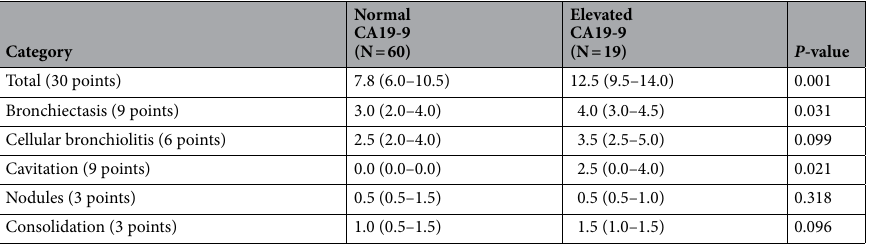
Table 3. CT scores of patients with pulmonary nontuberculous mycobacterial disease, according to the serum CA19-9 level. Values are presented as medians (Q1–Q3). CT computed tomography, CA carbohydrate antigen.